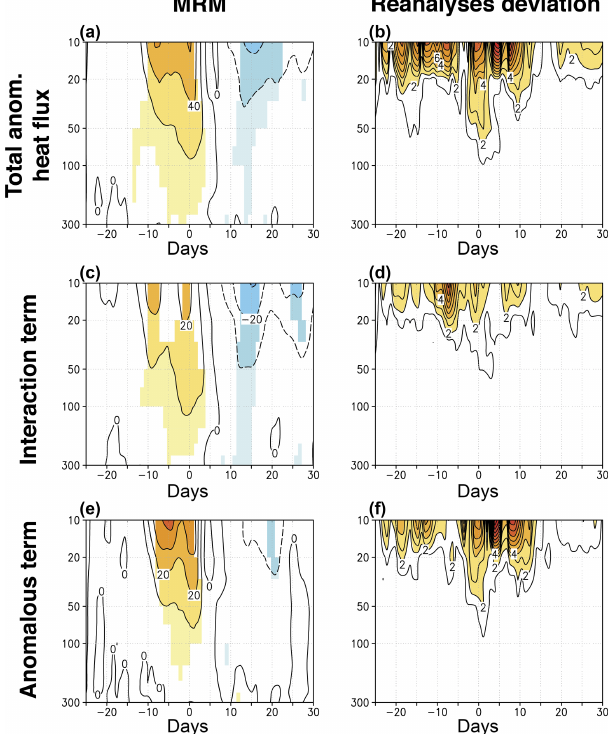
Figure 4. (a) Composited time evolution of the total anomalous heat flux averaged over 45–75 ◦ N (Kms − 1 ) at different pressure levels from 29d before to 30d after the occurrence of SSWs in the histor- ical period (1958–1978). Contour interval is 20Kms − 1 . (b) Same as (a) but for the standard deviation of the reanalyses with respect to the MRM divided by the square root of the number of reanaly- ses. Contour interval is 1Kms − 1 . (c, d) Same as (a) and (b) but for the interaction between climatological and anomalous waves. Contour intervals are 10 and 2Kms − 1 , respectively. (e, f) Same as (a) and (b) but for the contribution of the anomalous waves to the total anomalous heat flux. Contour intervals are 10 and 2Kms − 1 , respectively. Shading in (a) , (c) , and (e) denotes statistically signif- icant anomalies at the 95% confidence level of the same sign in at least 66.7% of all reanalyses (Monte Carlo test).